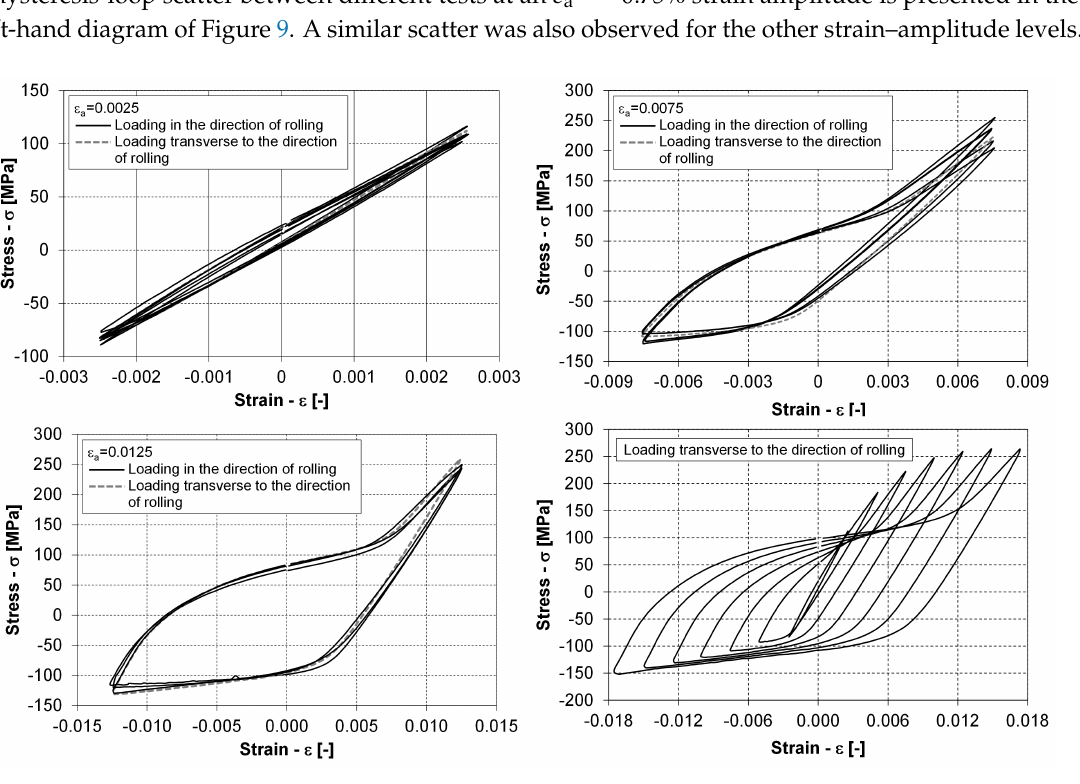
Figure 9. Scatter of stabilised hysteresis loops from different test runs at: ε a = 0.25% (top left); ε a = 0.75% (top right); and ε a = 1.25% (bottom left); and distribution of stabilised hysteresis loops from a step-wise test run (bottom